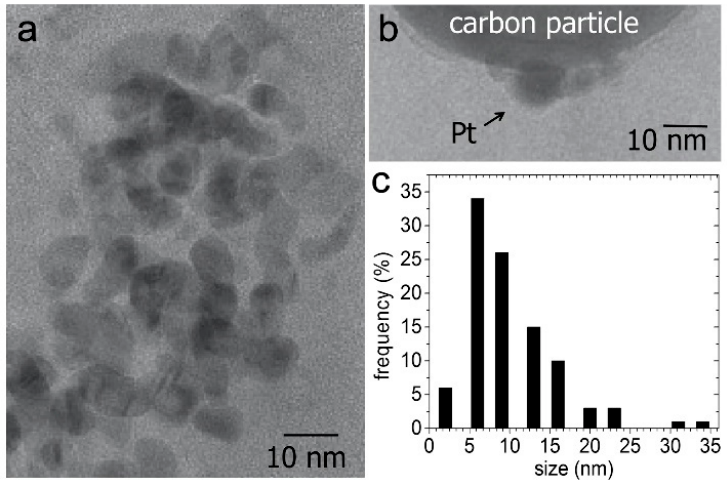
Figure 11. Representative TEM images of ( a ) Pt nanoparticles, and ( b ) Pt nanoparticles formed